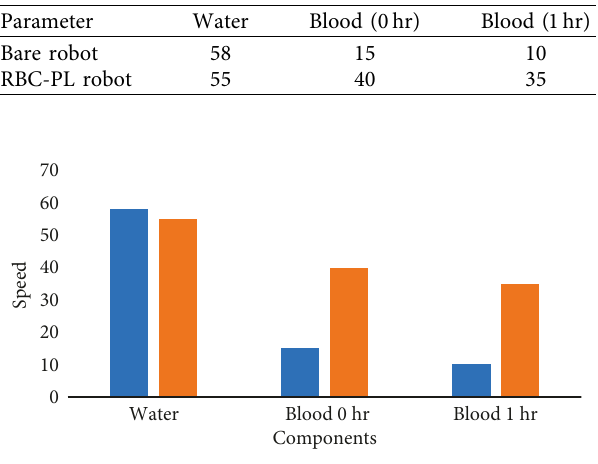
Figure 5: Performance of propulsion and RBC-PL robot’s antibiofouling belongings. Table 2: Comparison of the bare robot’s speed using RBC-PL robots.